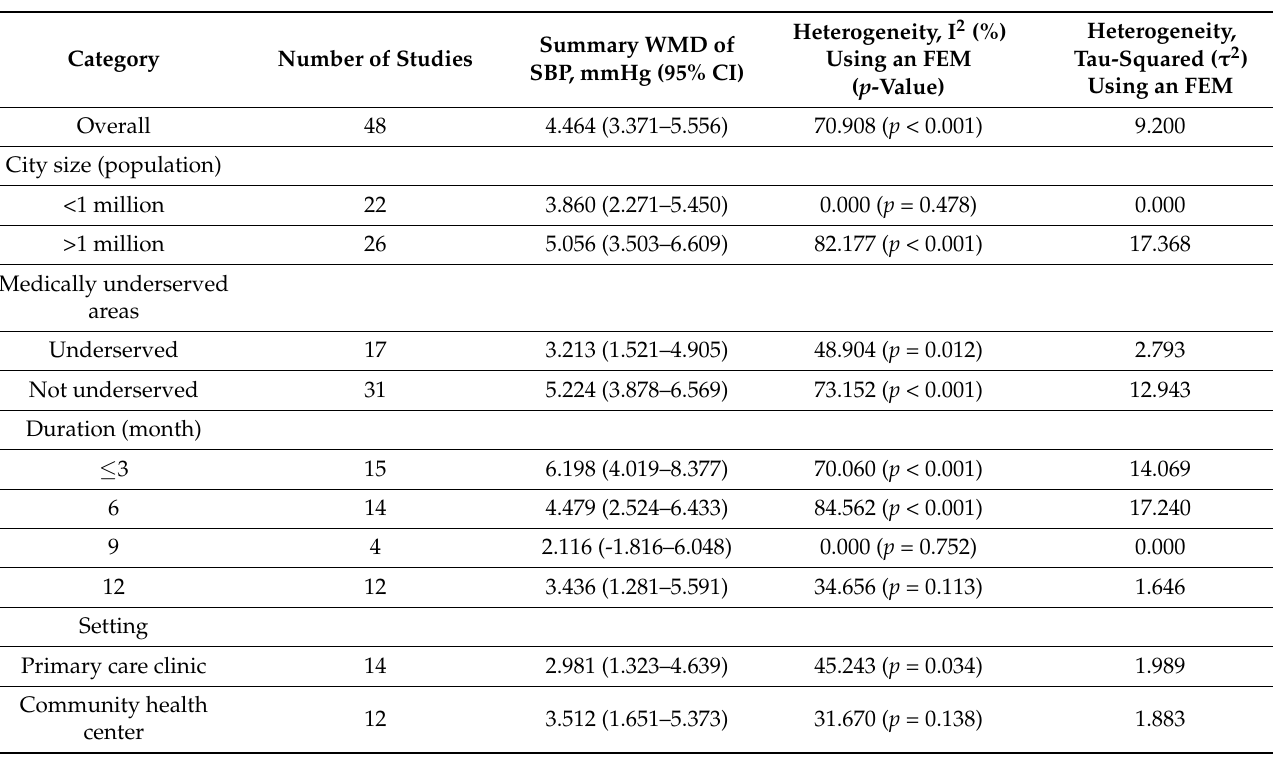
Table A1. CI, confidence interval; FEM, fixed effects model; SBP, systolic blood pressure; WMD, weighted mean differ- ence.